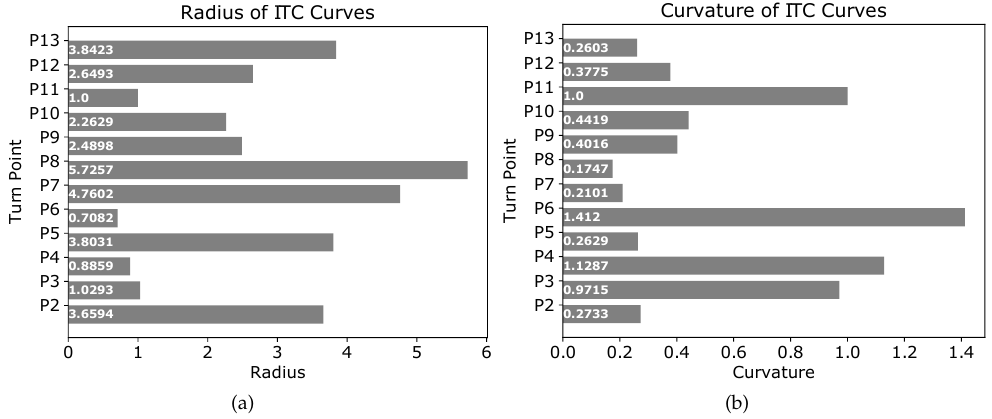
Figure 9. Radius and curvature of the different curves in Figure 8a. ( a ) radius of curves at different points; ( b ) curvature of curves at different